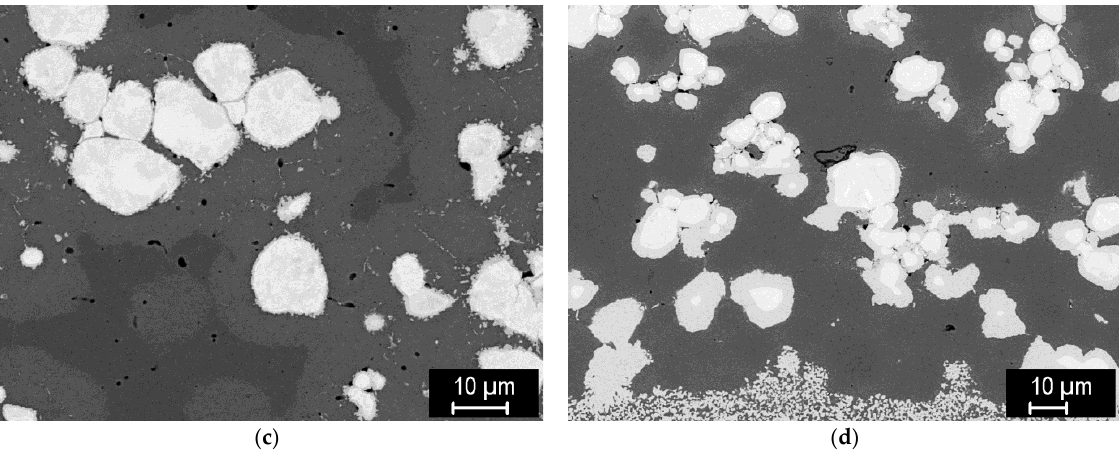
Figure 9. Microstructures of tungsten-steel composites sintered at 1100 °C. ( a ) 75% W, ( b ) 50% W, ( c ) 25% W, ( d ) 25% W, near the sample surface.